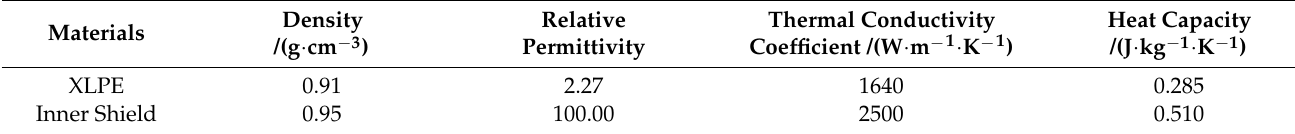
Table 2. Material properties specified in electric-thermal coupling simulations.